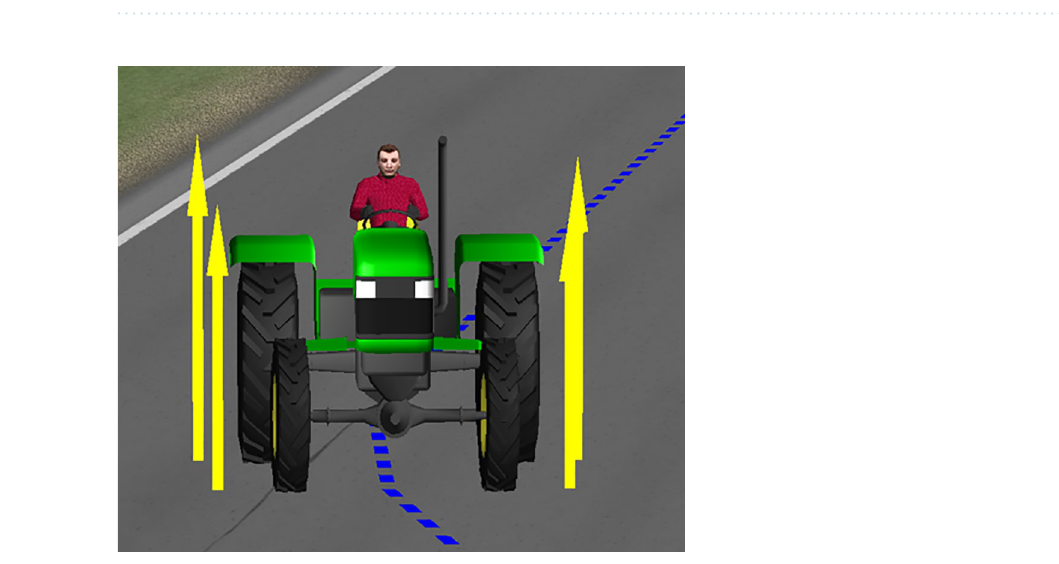
Figure 25. Tracking effect at 10 km h −1 .